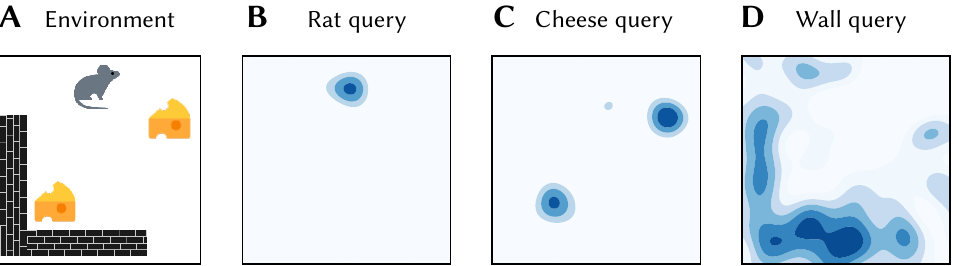
Figure 9. Map encoding using SSPs. ( A ) A 2D environment consisting of a rat, walls, and cheese. Information about the objects and their locations was encoded in single vector E , as per Equation (5). ( B ) The vector E was queried for the location of the rat by approximate unbinding: E (cid:126) R − 1 ≈ φ ( x 1 , y 1 )+ noise. The cosine similarity between the query output and SSP representations of points gridded over 2D space was computed and plotted to produce the above heat map. ( C ) The similarity map obtained from querying the map E for the location of cheese. ( D ) The similarity map obtained from querying for the wall